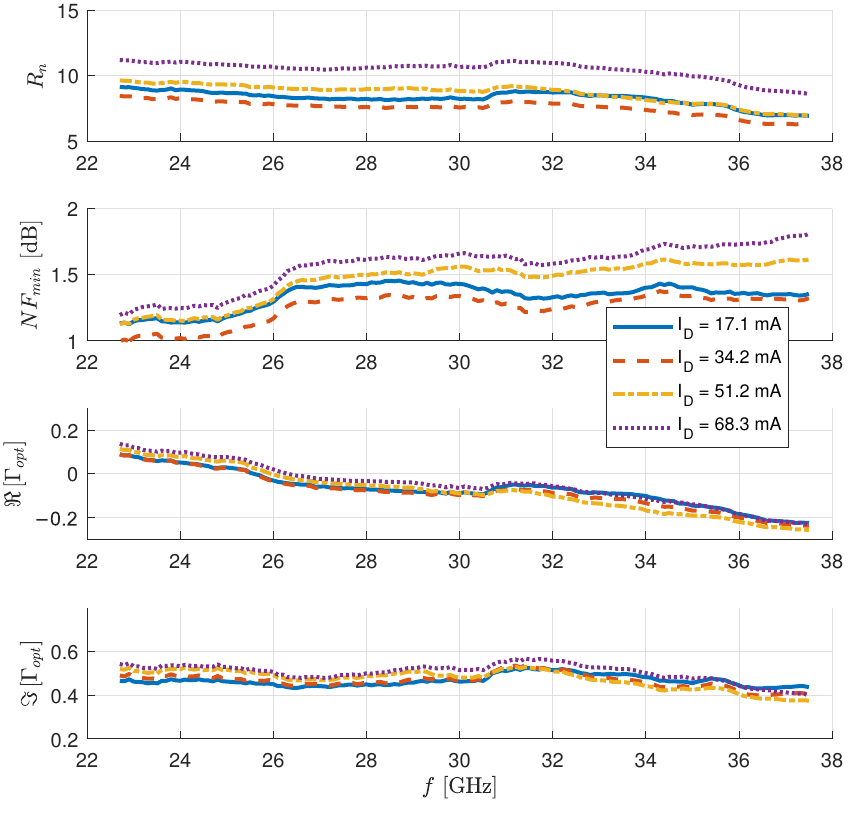
Figure 6. Extracted noise parameters over frequency at different current